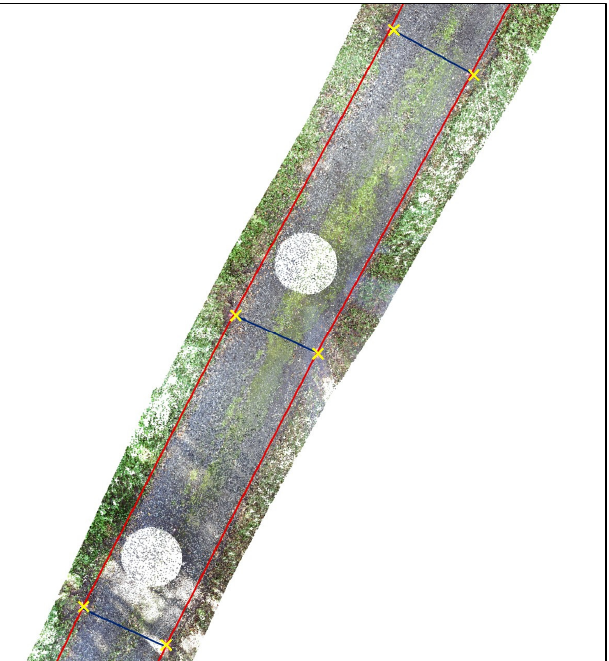
Figure 4. Measurement of lengths in the direction of the path between reference crosses (red lines) and in transverse profiles (blue lines)—example from section No.1.